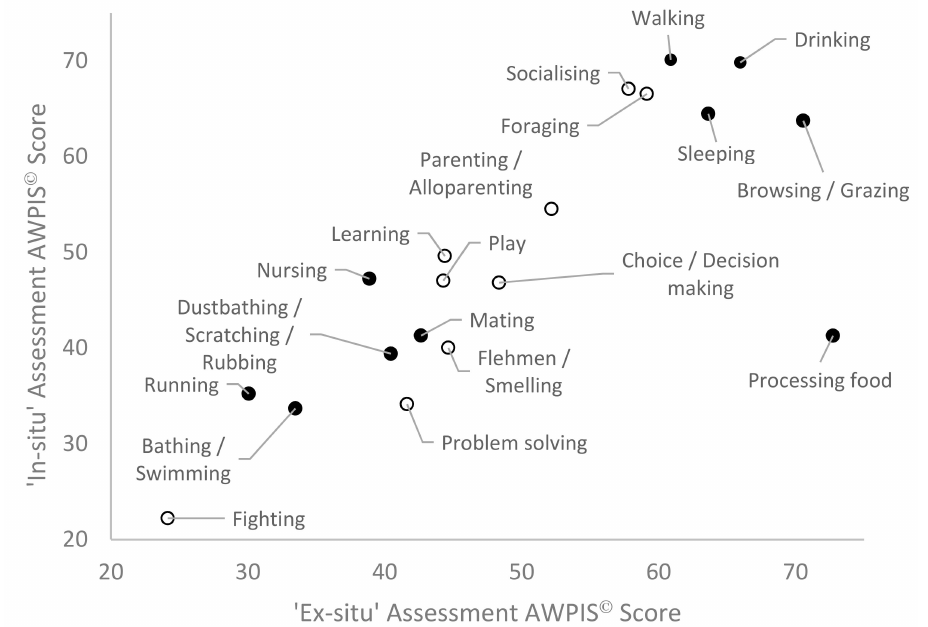
Figure 1. Correlation of AWPIS © scores for Asian elephant behaviours and cognitive processes provided by two independent assessments; Pearson’s correlation n = 19, r = 0.789, p ≤ 0.001. Open circles denote cognitive process or behaviours with significant cognitive components to them.